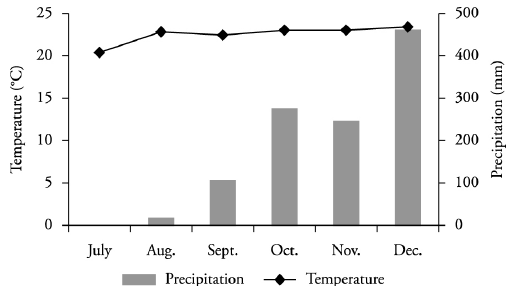
Figure 2. Average temperature (° C) and average total precipitation (mm) of the second half of 2006, recorded monthly in Uberlândia (MG) by Universidade Federal de Uberlândia Climatological